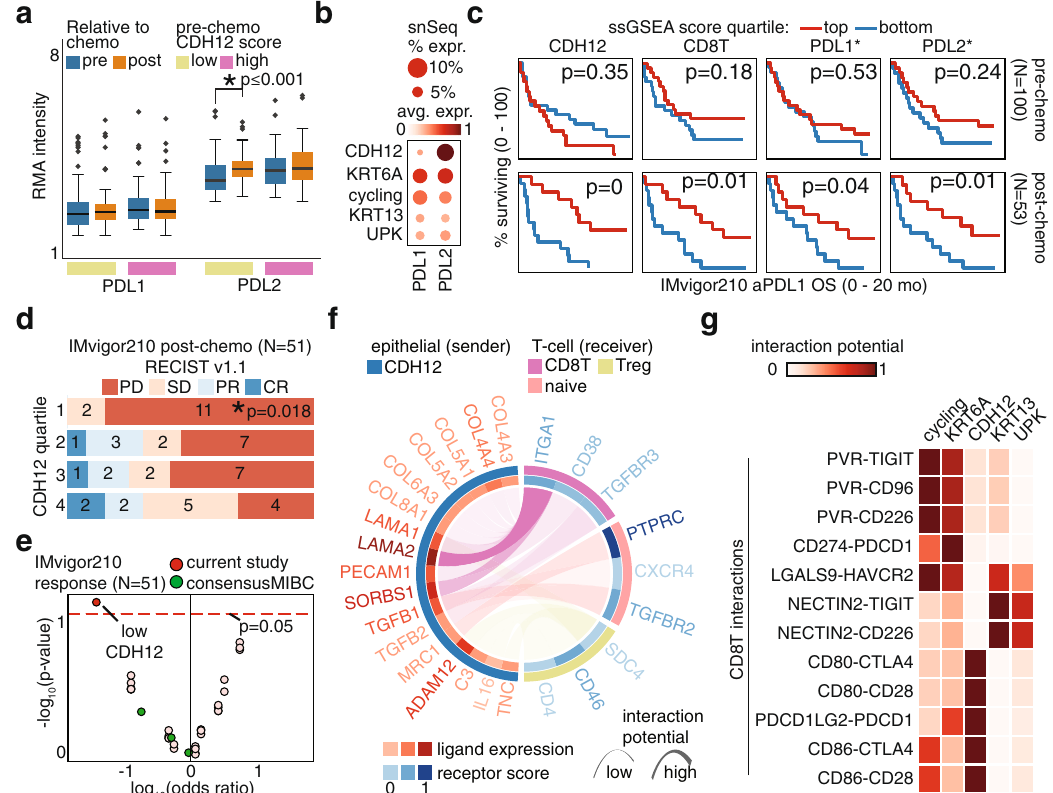
Fig. 4 Post-chemo CDH12 score predicts favorable response to immune checkpoint therapy. a PDL1 and PDL2 in matched pre-chemo and post-chemo samples (* - Wilcoxon paired two-sided rank-sum test p <0.05; n = 65 for low CDH12, n = 49 for high CDH12). Boxplots are drawn as the inter-quartile range (IQR) with a line indicating the median, and outliers de fi ned as points that fall outside of the range demarcated by 1.5*IQR. Source data are available as a Source data fi le. b PDL1 and PDL2 expression in snSeq tumor epithelial cells. c Overall survival in IMvigor 210 Cohort 2 bladder tumors sequenced pre-chemo (top, N = 100) or post-chemo (bottom, N = 53) strati fi ed by snSeq-derived population signature scores, or gene expression value (log-rank test, p = 0 indicates p